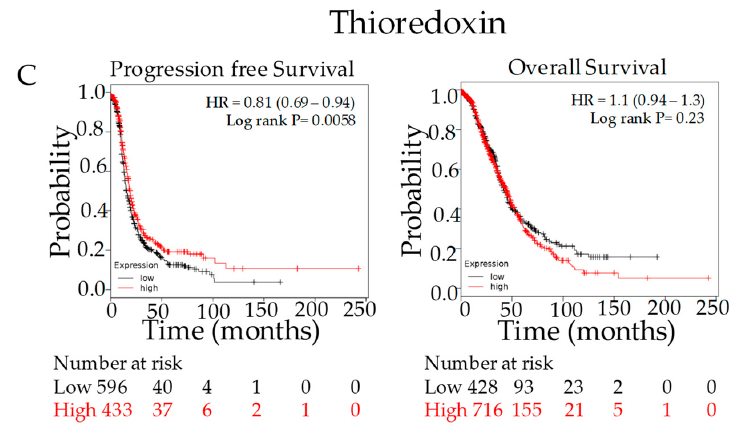
Figure 4. Kaplan–Meier plot using online TCGA data. Kaplan–Meier analysis revealed that elevated levels of GSN ( A ) and TXN ( C ) mRNA expression correlated with better five-year OS and PFS rates, respectively. CALM1 ( B ) expression was not associated with OS or PFS. Analysis was performed on data from 1648 ovarian cancer patients downloaded from Gene Expression Omnibus and The Cancer Genome Atlas using the Kaplan–Meier Plotter (http://kmplot.com/ assessed on 12 January 2022). Higher expression is shown in red while low is shown in black.